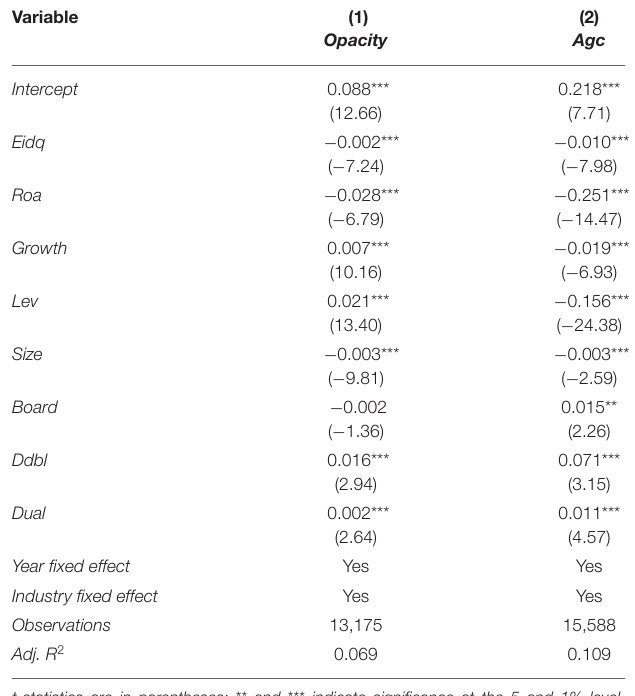
TABLE 12 | Univariate test.